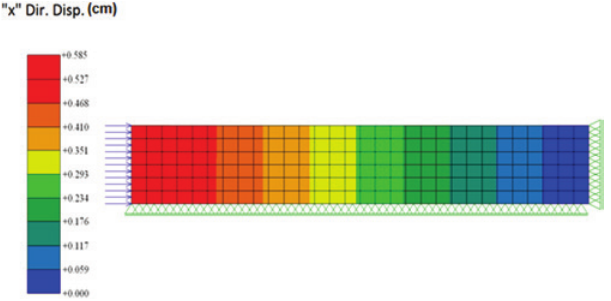
Figure 9 Longitudinal displacement field due to creep at 4000 days – Case 25